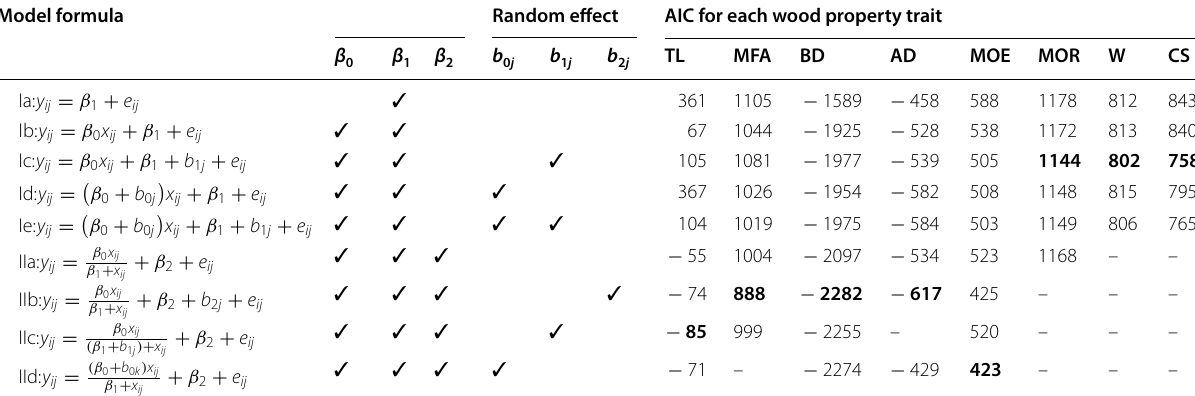
Table 4 Comparison of AIC values in the linear and nonlinear mixed-models for radial variations in relation to cambial age